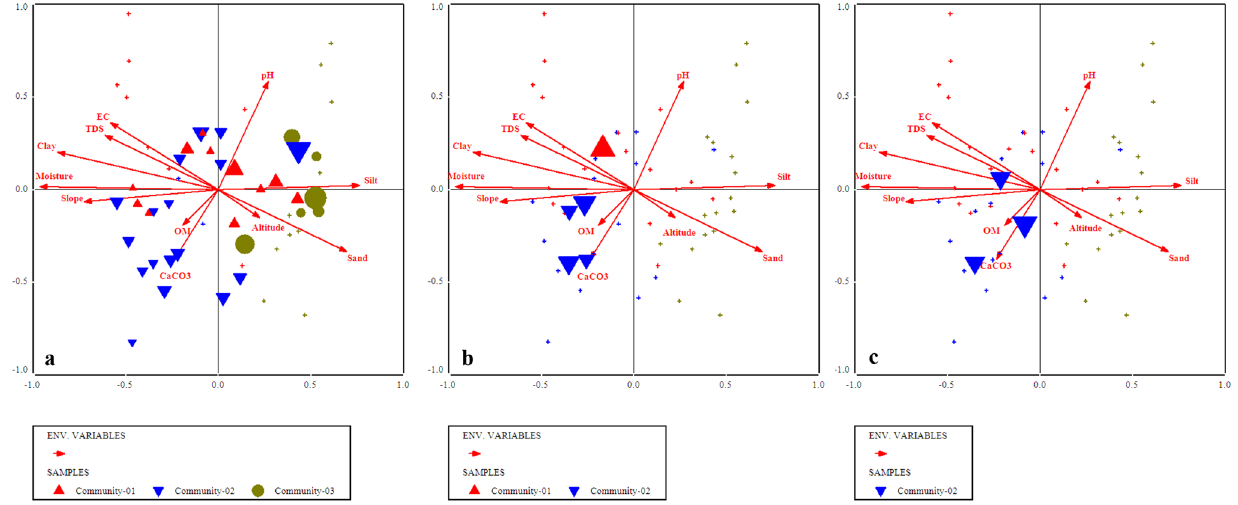
Figure 8. Indicator species biplots for (a) Abies pindrow, (b) Rubus fruticocus and (c) Poa annua in relation to various environmental factors.